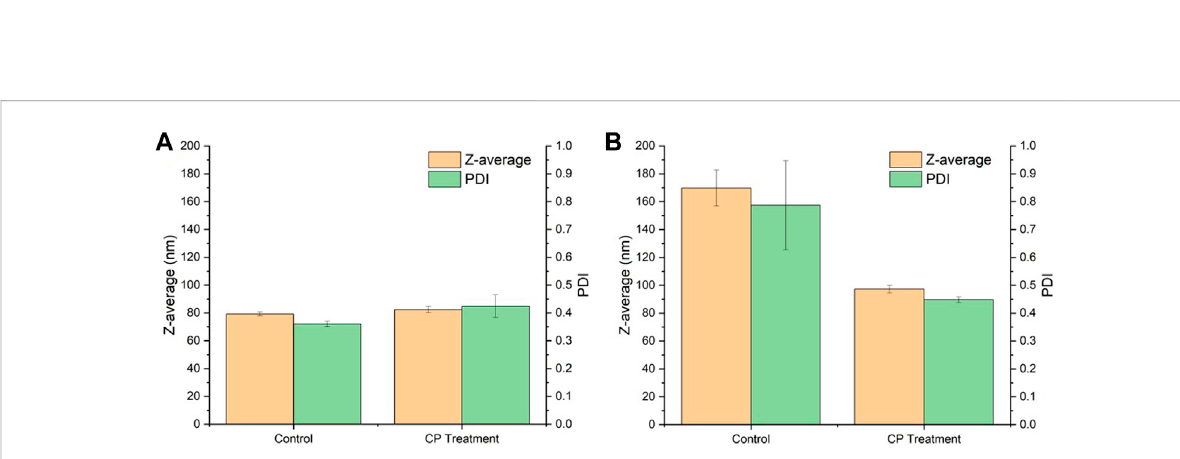
particles are smooth, and the particles mainly exhibit round, oval, consistent with other research (Kim et al., 2013; Wang et al.,